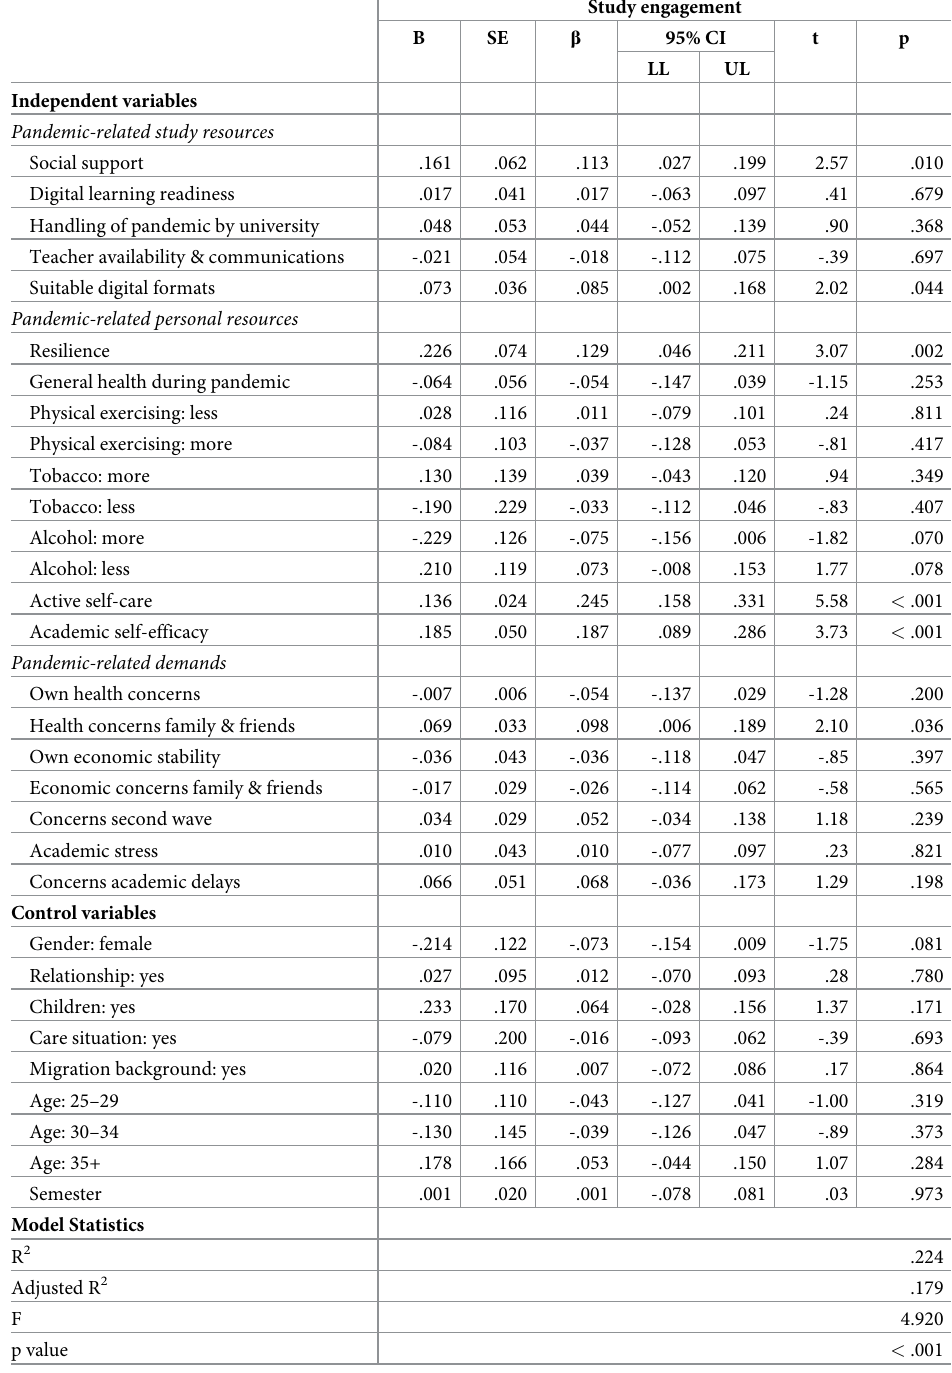
Table 3. Results of regression